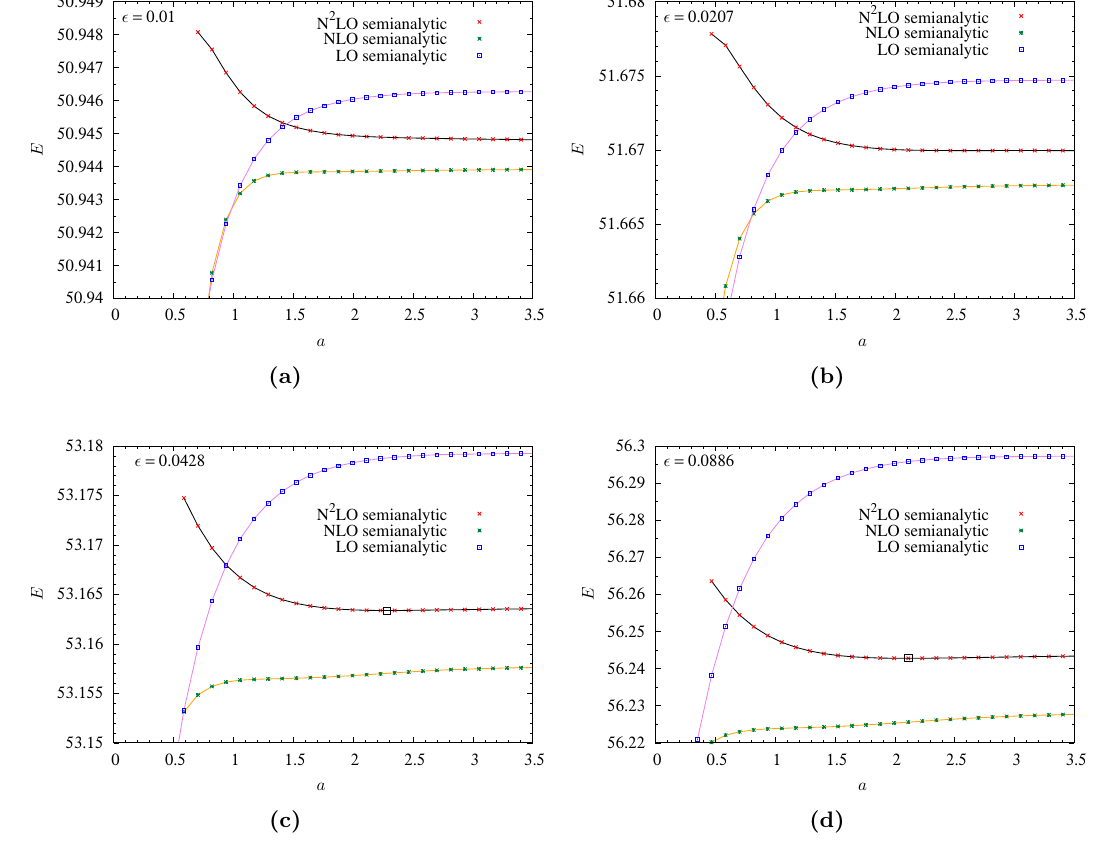
Figure 14. The LO (blue squares), NLO (green crosses) and N 2 LO corrections (red crosses) to the energy of two N = 2 baby Skyrmions as functions of the separation distance 2 a , see figure 13. The panels show different values of (cid:15) : (a) (cid:15) = 0 . 01 , (b) (cid:15) = 0 . 0207 , (c) (cid:15) = 0 . 0428 and (d) (cid:15) = 0 . 0886 . The LO energy is calculated by geometrically cutting off the BPS energy plus the LO correction at the gluing line ( x 1 = 0 ) (and multiplying by 2). A large black square shows the minimum of the N 2 LO energy in panels (c) and